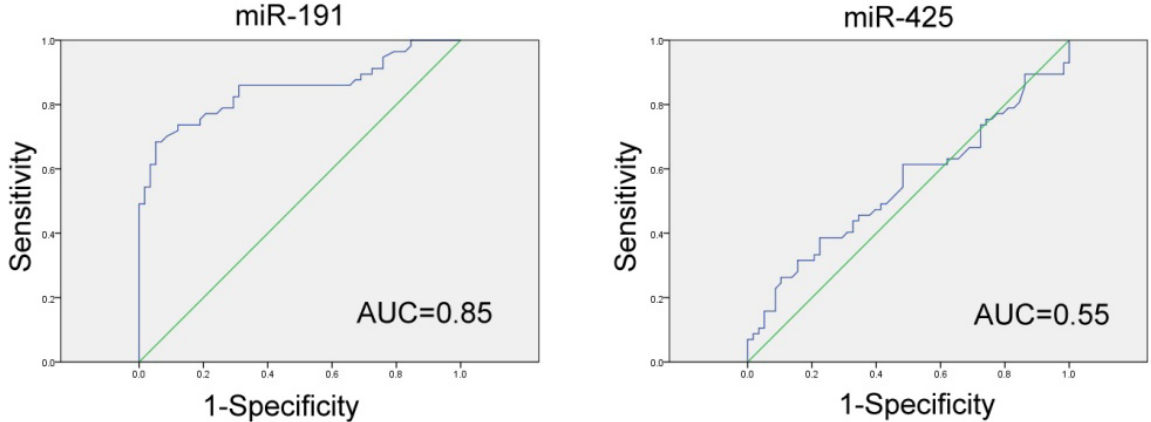
Figure 3. Receiver–operator characteristic (ROC) curve analysis using serum miRNAs for discriminating the GC group from the controls. Abbreviation: AUC, area under the ROC